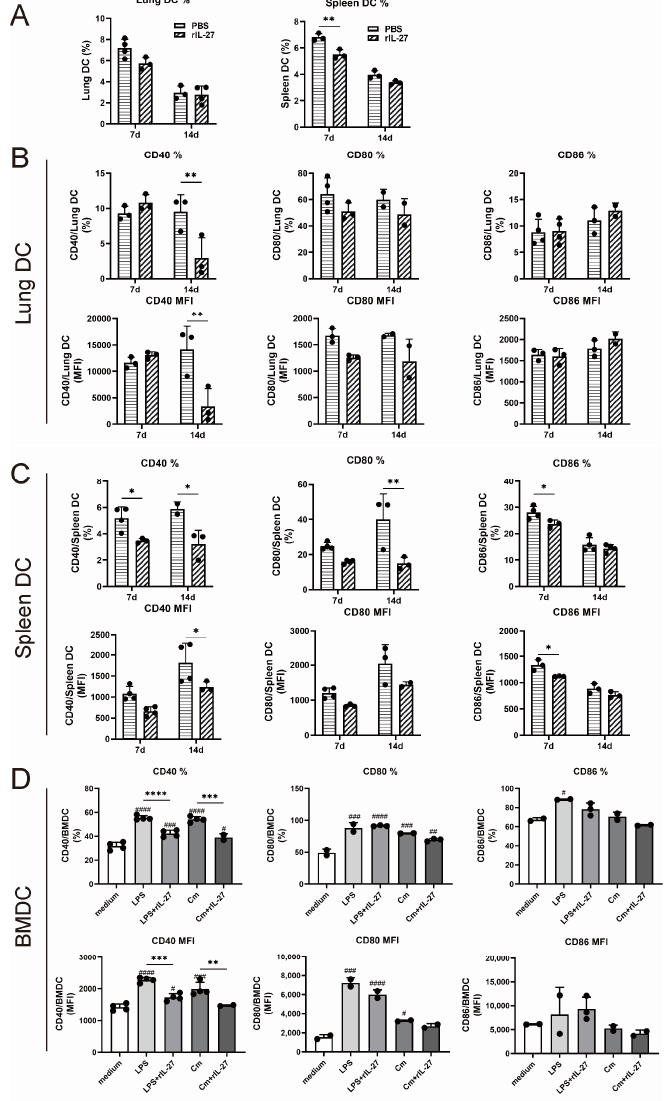
Figure 5. DCs accumulation and phenotypic maturation after rIL-27 administration against